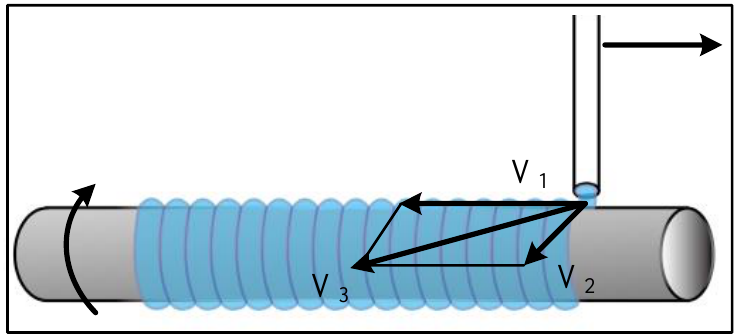
Figure 11. Spiral printed feed velocity vector plot.